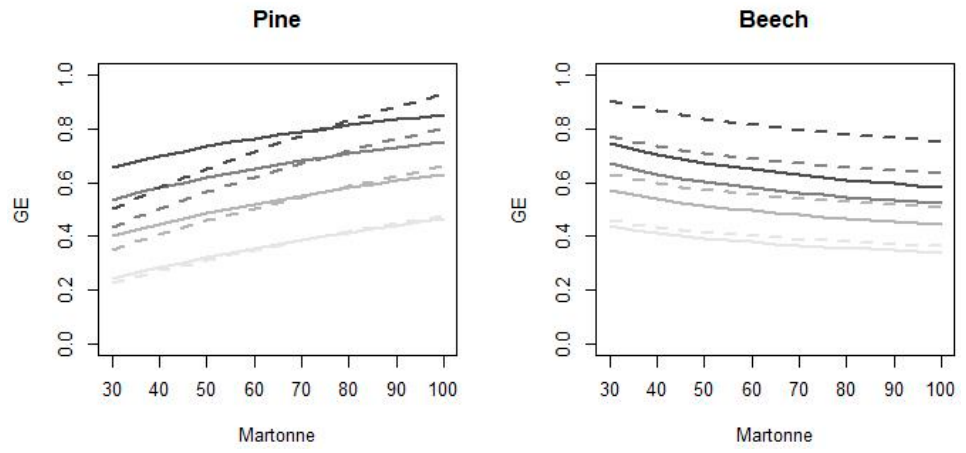
Figure 4. Comparison between the influence of humidity on the basal growth efficiency (GE m 2 ha − 1 year − 1 ) of monospecific stands (solid lines) and mixed stands with proportion of competitor species 0.5 (dashed lines), from the least dense ( RD = 0.2 light grey) to the most dense stands ( RD = 0.8 dark grey), increased gradually by 0.2.